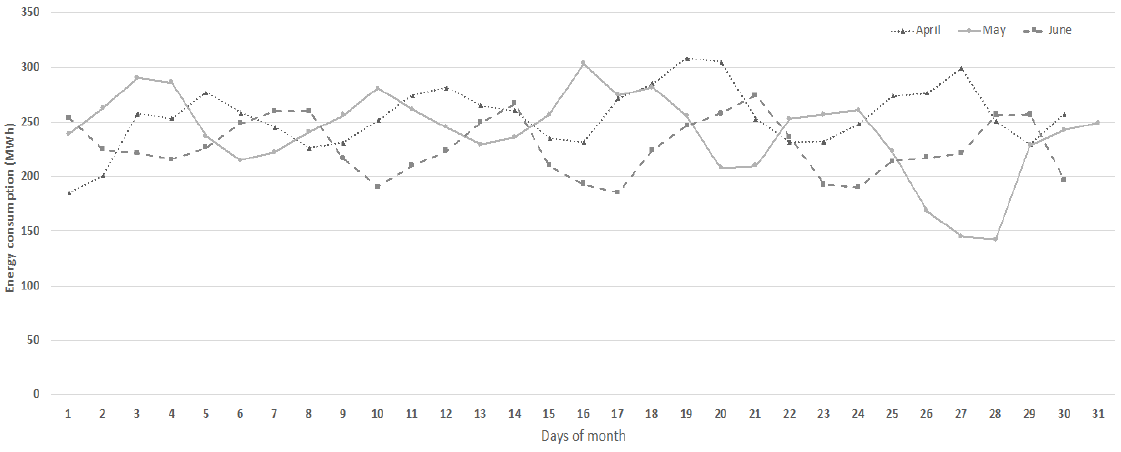
Figure 9. Energy consumption in spring, 2018.